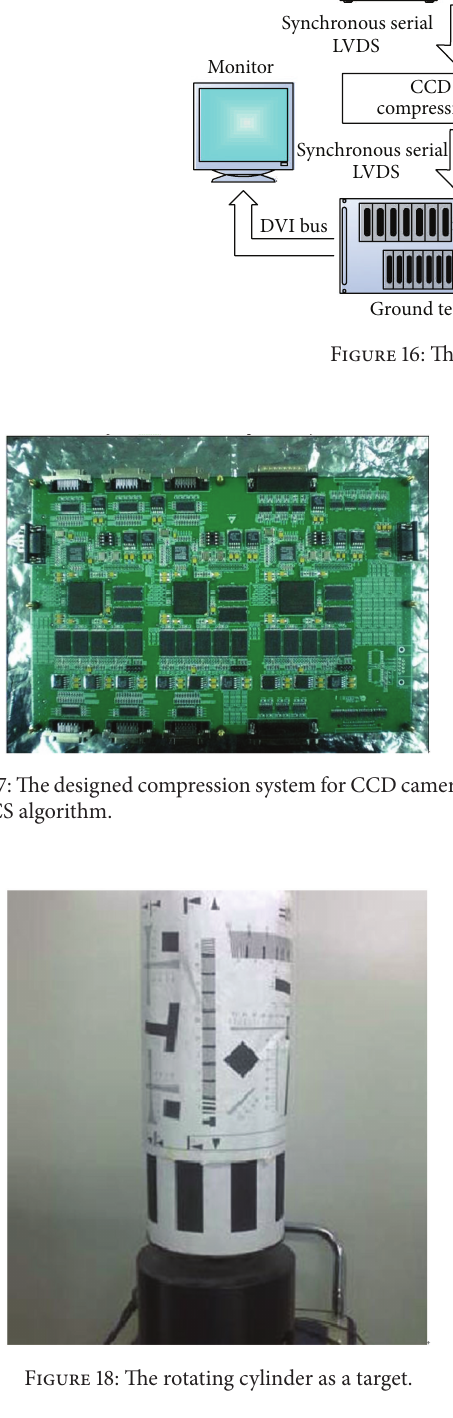
of most pixels are about 1 bit. So, the proposed algorithm is validation for space CCD image compression.